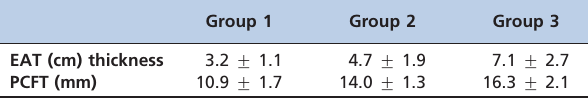
EAT: Epicardial adipose tissue PCFT: Pericoronary fat tissue Group 1: No atherosclerosis Group 2: Nonobstructive atherosclerosis (luminal narrowing , 50% in